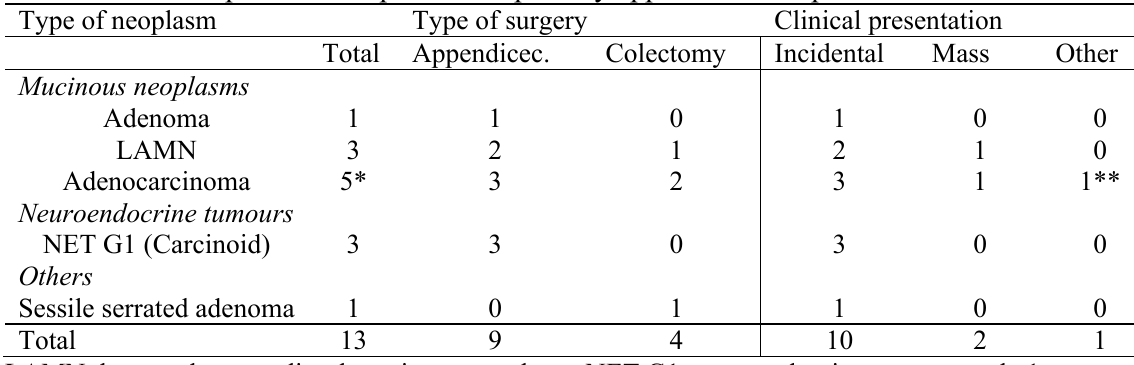
Table 1 . Clinical presentation patterns of primary appendiceal neoplasms